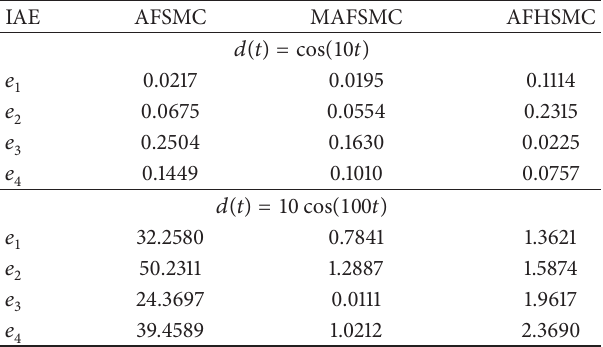
Table 2: Integral absolute error (IAE) values for various